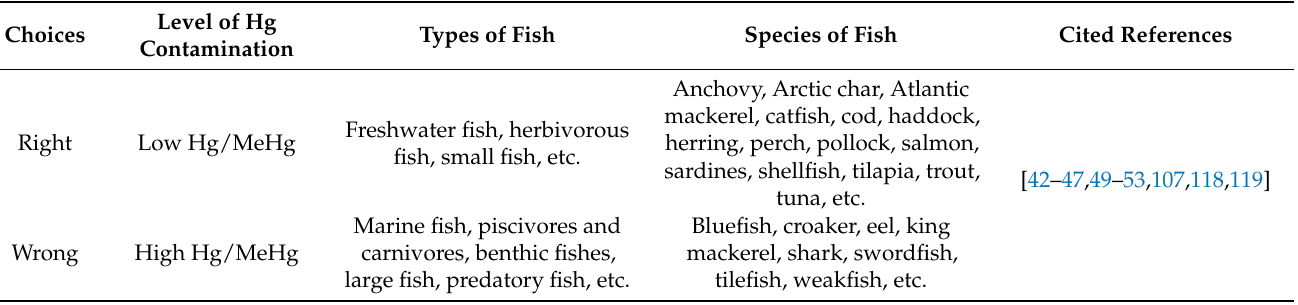
Table 1. Choice guidelines for species and types of fish based on Hg contamination for daily fish consumption for pregnant